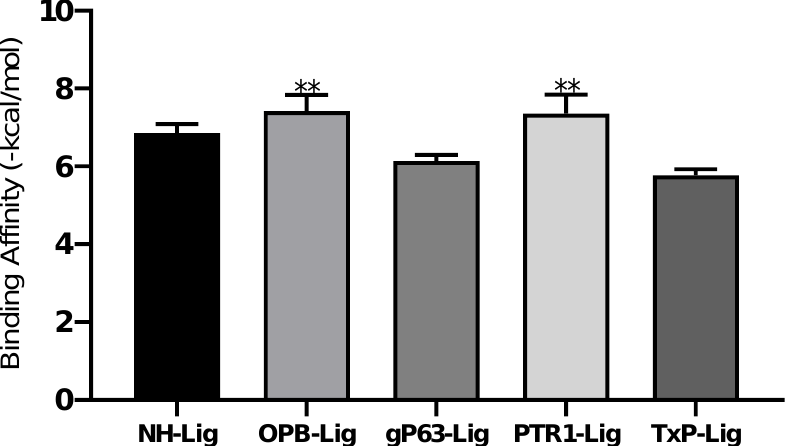
Figure 2. Interaction affinity between IPG and the molecular targets under study. Nucleoside hydrolase (NH); oligopeptidase B (OPB); leishmanolysin proteinase (gp63); pteridine reductase (PTR1); triparedoxin peroxidase (TxP). Two asterisks (**) Represents the molecular targets (OPB and PTR-1) that showed better binding interaction with IPG.